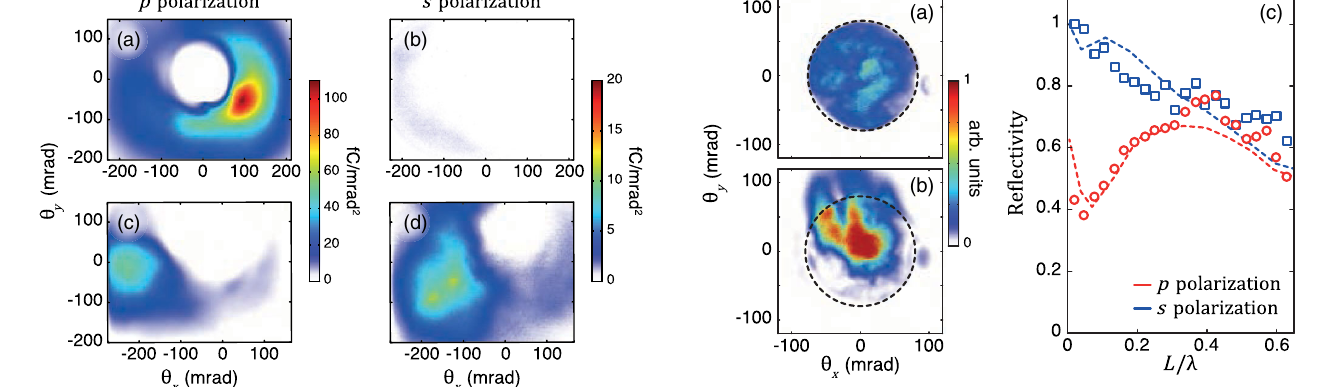
FIG. 4. Effect of the laser polarization direction on relativistic electron emission. Panels (a) and (b) show the angular profiles of the relativistic electron emission for a gradient scale length L ¼ λ = 15 , respectively for p and s polarizations of the incident 1 laser. In both cases, the laser incidence angle is θ i ¼ 55 °. Panels (c) and (d) show these electron angular distributions, now measured for a longer gradient L 2 ¼ λ = 1 . 5 , i.e., beyond the transition observed in Fig. 3. Note the different color scales used in (a) and (c) versus (b) and (d).